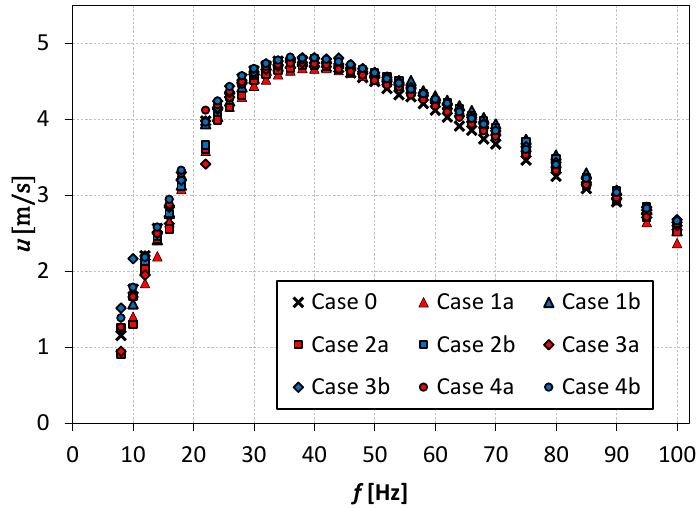
Figure 4. SJ velocity vs. the actuator frequency at power 3 W.